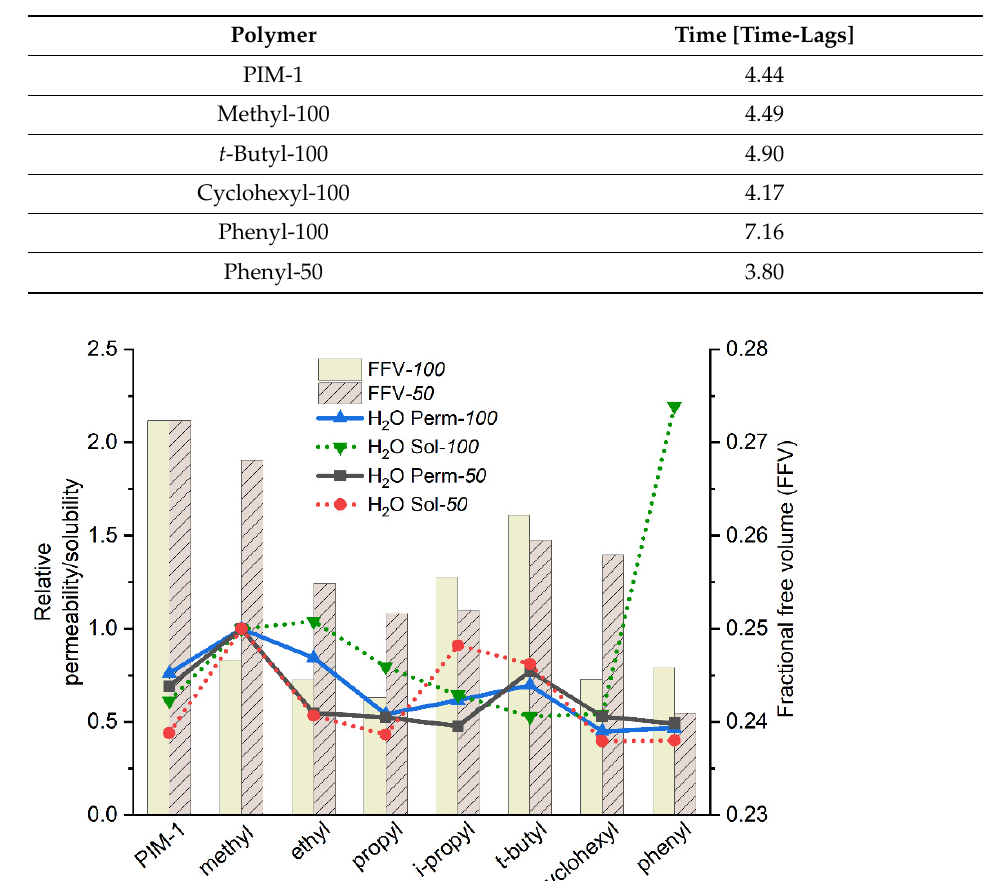
Figure 13. H 2 O relative permeability and relative solubility and FFV of copolymer and homopoly- mers. (Relative permeability/ solubility: polymer water permeability or solubility are normalized to methyl- water permeability or solubility.)